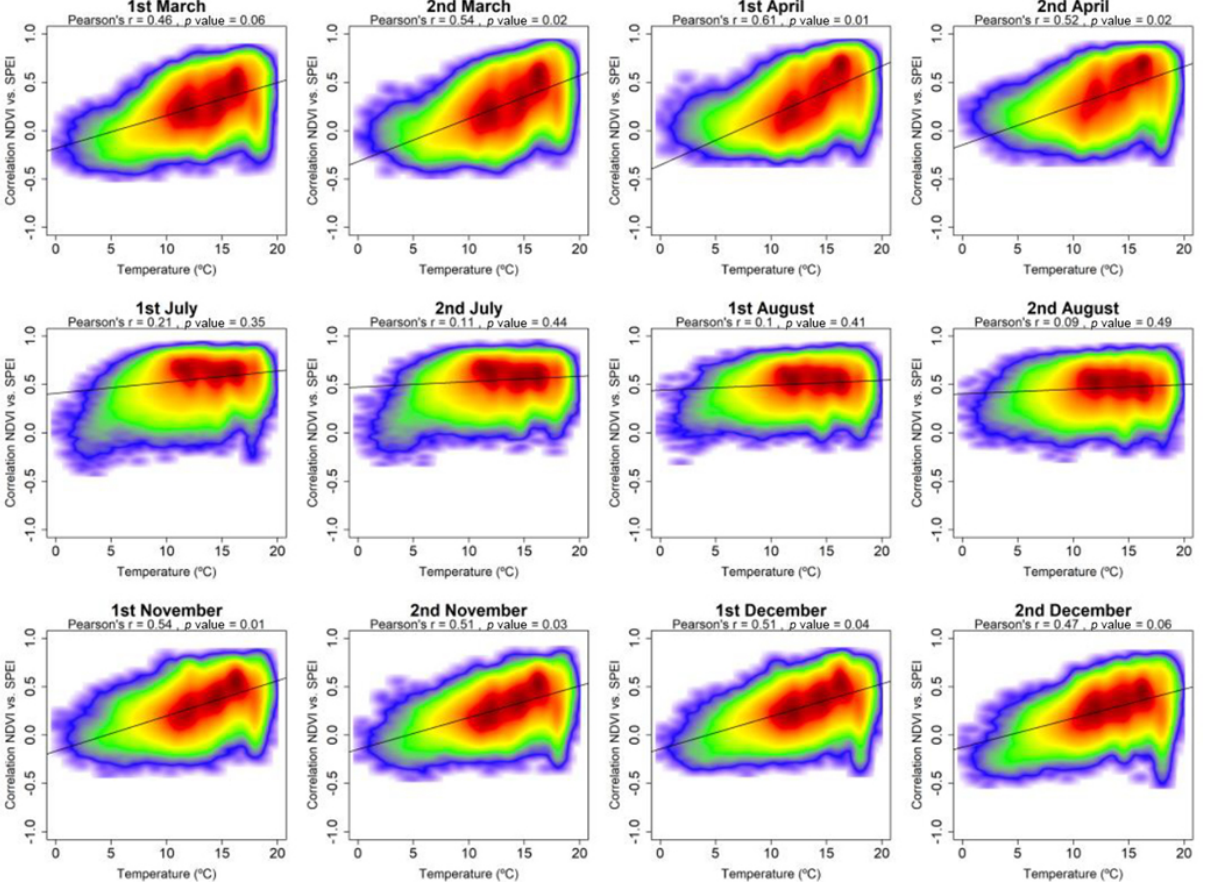
Figure 9. Scatterplots showing the relationships between the maximum correlation obtained between the sNDVI and the SPEI and the average air temperature. Given the high number of points, the significance of correlation was obtained by means of 1000 random samples of 30 cases from which correlations and p values were obtained. The final significance was assessed by means of the average of the obtained p